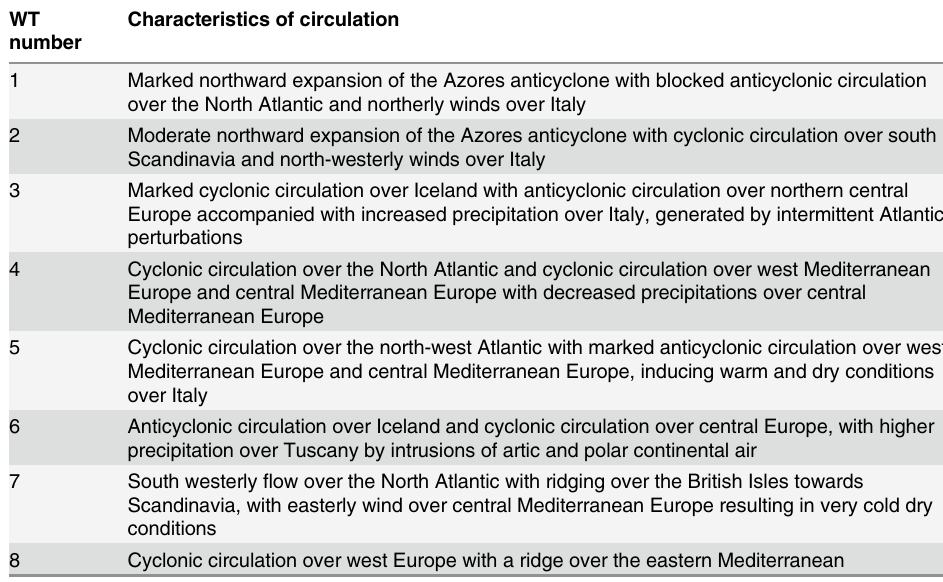
Table 1. The most common Weather Types (WT) in Europe and prevailing circulation in